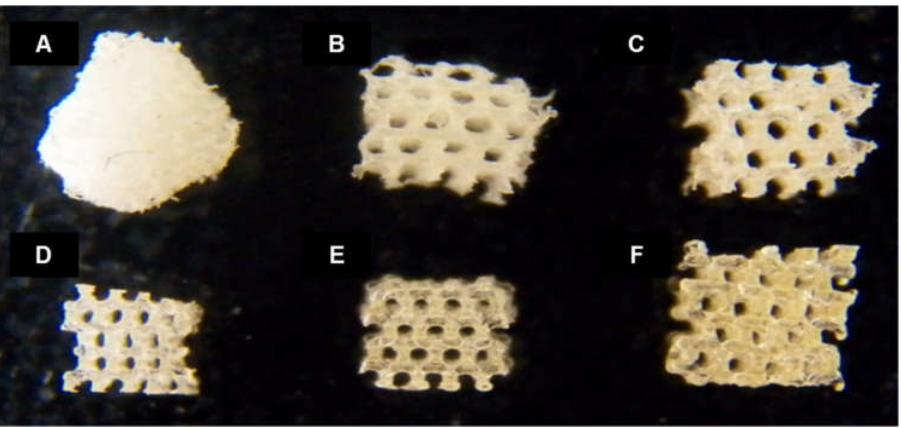
Figure 4. Images of ( A ) salt-leached, ( B ) 10% aqueous, ( C ) 20% aqueous, ( D ) 10% HFIP-based, ( E ) 20% HFIP-based, and ( F ) 30% HFIP-based SF scaffolds. Controlled pore shape and size were observed in all of the SF scaffolds manufactured through indirect 3D printing. The aqueous-based SF scaffold was white while the HFIP-based SF scaffold was a transparent yellowish color. faces than the aqueous SF scaffold. In addition, the aqueous SF scaffold was observed to have a microporous surface, which could be due to the extra freeze-drying step prior to IPA treatment. On the other hand, in the HFIP-based SF scaffold, there is no microporous structure on the surface of the scaffold because the HFIP was slowly removed by IPA, thereby allowing the SF molecules to come close to each other. This property can also affect biodegradation. It has been reported that an aqueous SF scaffold with a microporous structure has a faster biodegradation rate than the HFIP-based SF scaffold with a relatively smoother surface [22]. When using an indirect mold scaffold fabrication method, the concentration of the injected biomaterial solution is very important for securing high shape fidelity [21,23]. Therefore, we prepared the maximum concentration of SF in each solvent that could be used to fabricate the scaffolds. The aqueous and HFIP-based SF scaffolds could be fabri- cated with SF solution concentrations of up to 20% and 30%, respectively. Since the aque- ous SF solutions were prepared by dialyzing against 10 wt% polyethylene glycol, dialysis for preparing a 30% aqueous SF solution was carried out for a longer time than the 10% and 20% ones. In this process, β-sheet formation of the aqueous SF solution can occur, resulting in gelation. On the other hand, HFIP, an organic solvent, has excellent SF solu- bility that made it possible to fabricate a scaffold with an SF concentration of 30%.